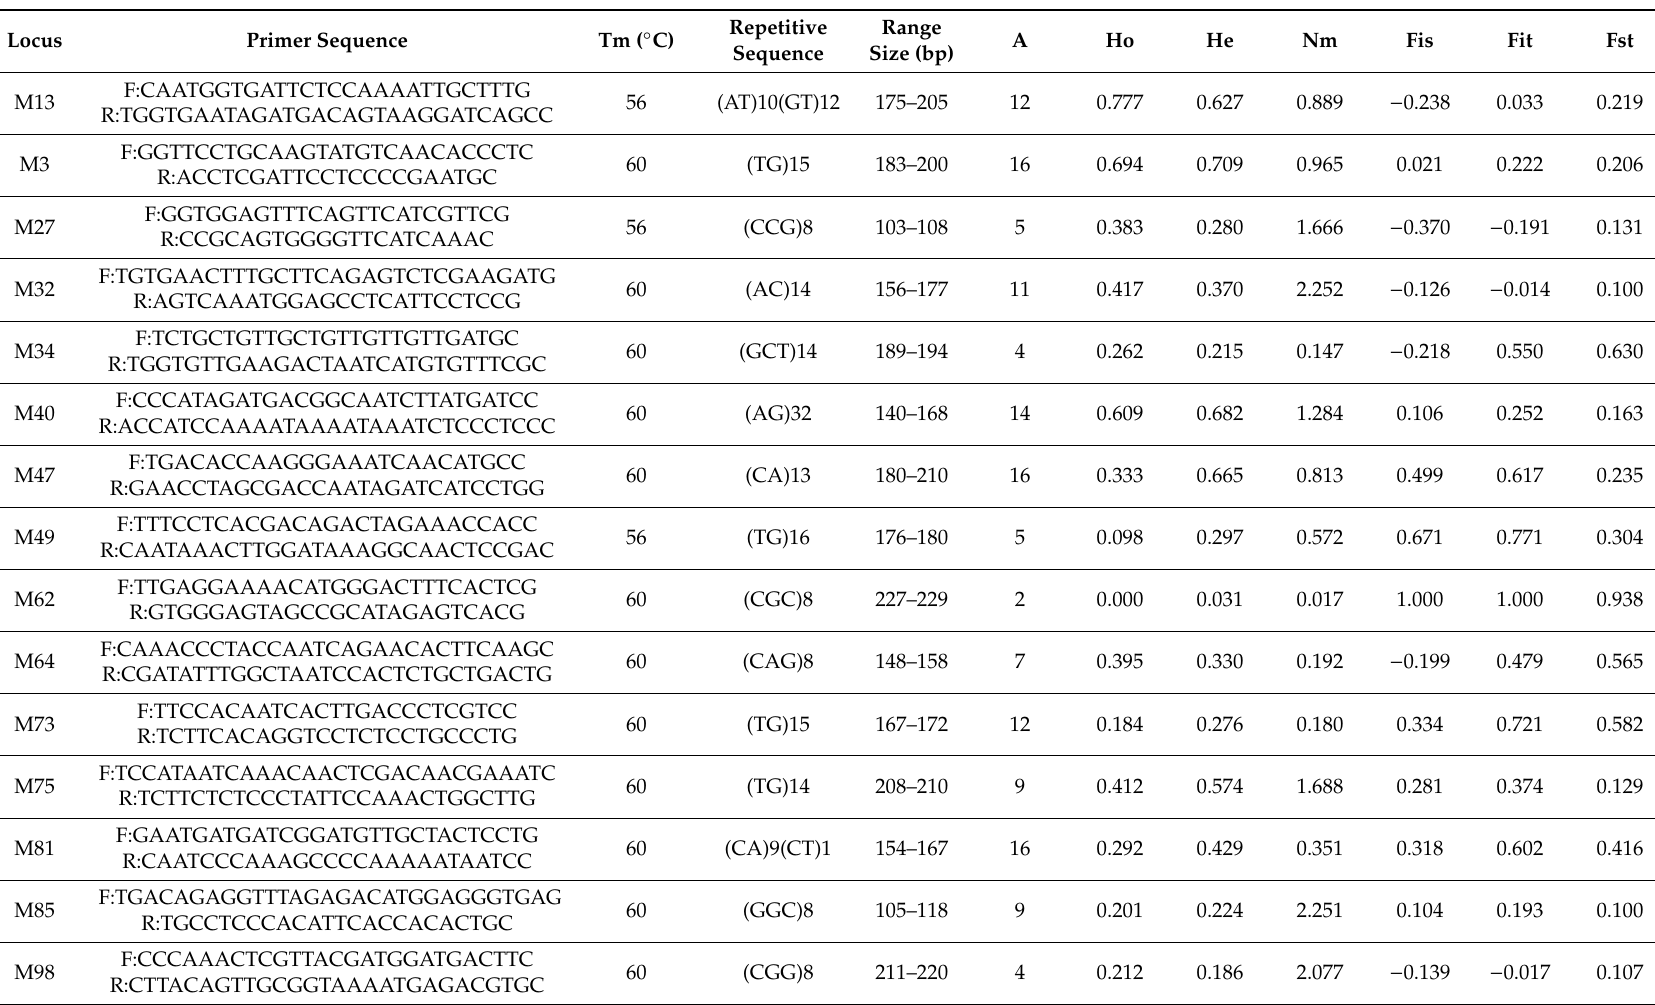
Table 3. Simple Sequence Repeat (SSR) primers screened for SSR-polymerase chain reaction (PCR) in A. marina: primer sequence, repetitive sequence, range size (bp), total number of alleles per primer over all localities (A), observed heterozygosity (Ho), expected heterozygosity (He), gene flow (Nm), and F-statistic (Fis, Fit, and Fst).